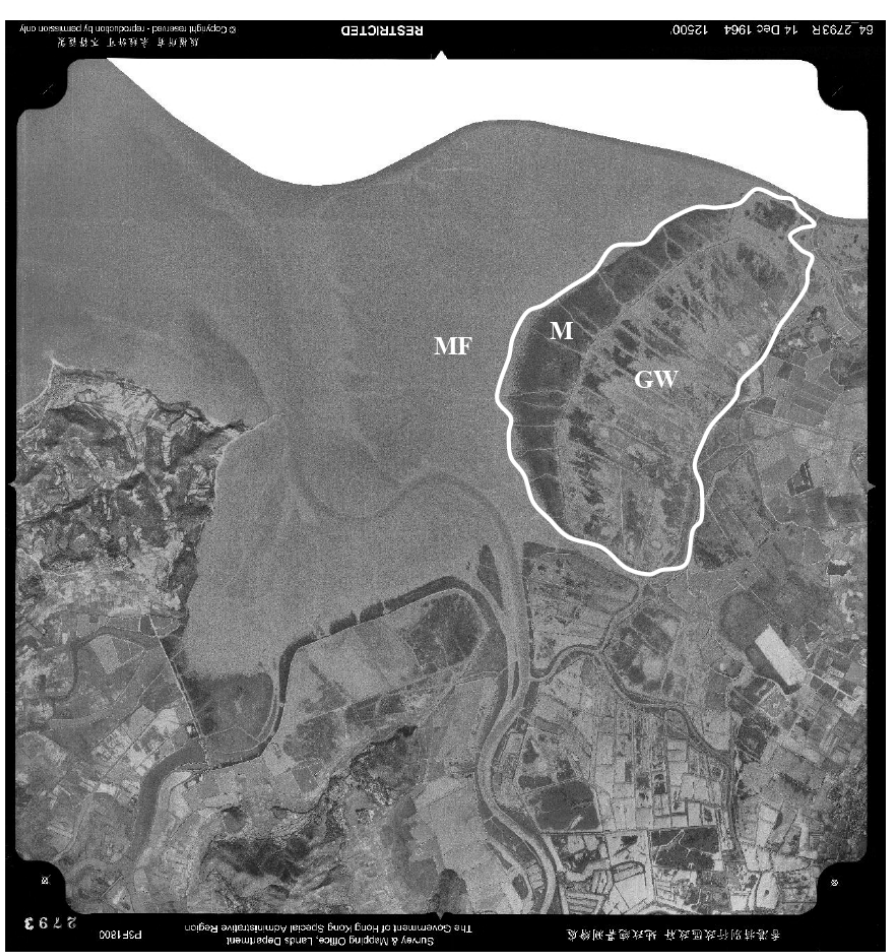
Figure 2. Aerial photo no. 1964-2793R taken on 14 December 1964, by Hong Kong Lands Department, showing the Mai Po Nature Reserve (area enclosed by white line) and the various wetland habitats: Mangroves (M), mudflat (MF) and gei wai (GW).